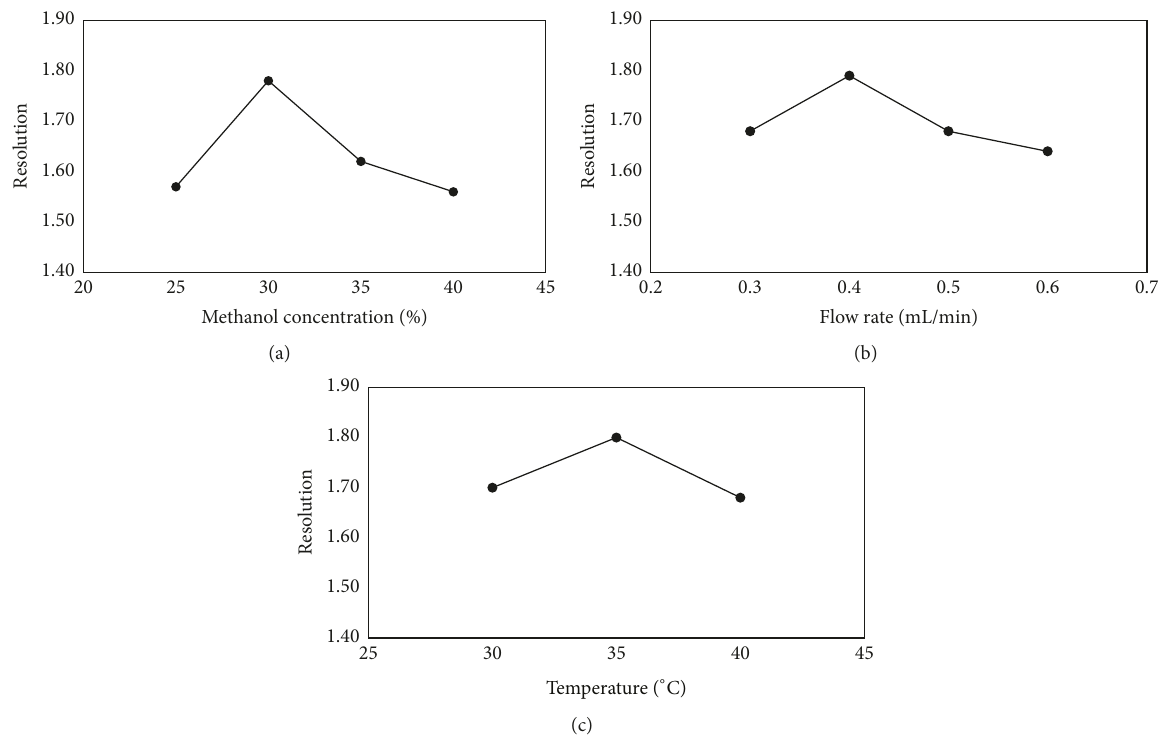
Figure 2: Effect of (a) methanol concentration, (b) flow rate, and (c) column temperature on the resolution of (R, S)-goitrin enantiomers. Experimental conditions: S-Chiral A column (4.6 mm × 250 mm, 5 𝜇 m), methanol/water, 245 nm, and injection volume of 10 𝜇 L.